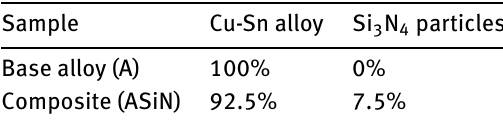
Table 2: Composition of prepared